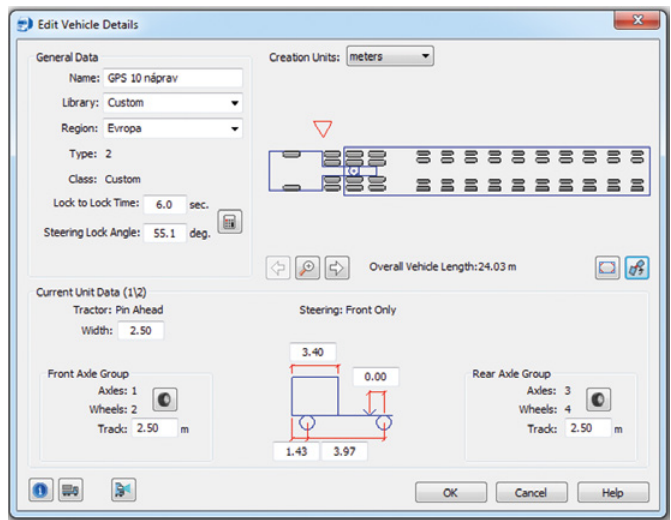
Figure 4. Modelling of a vehicle in AutoTURN